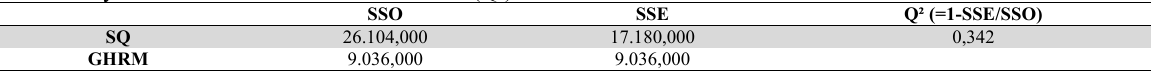
The summary of the results of Stone Geisser Value (Q 2 )